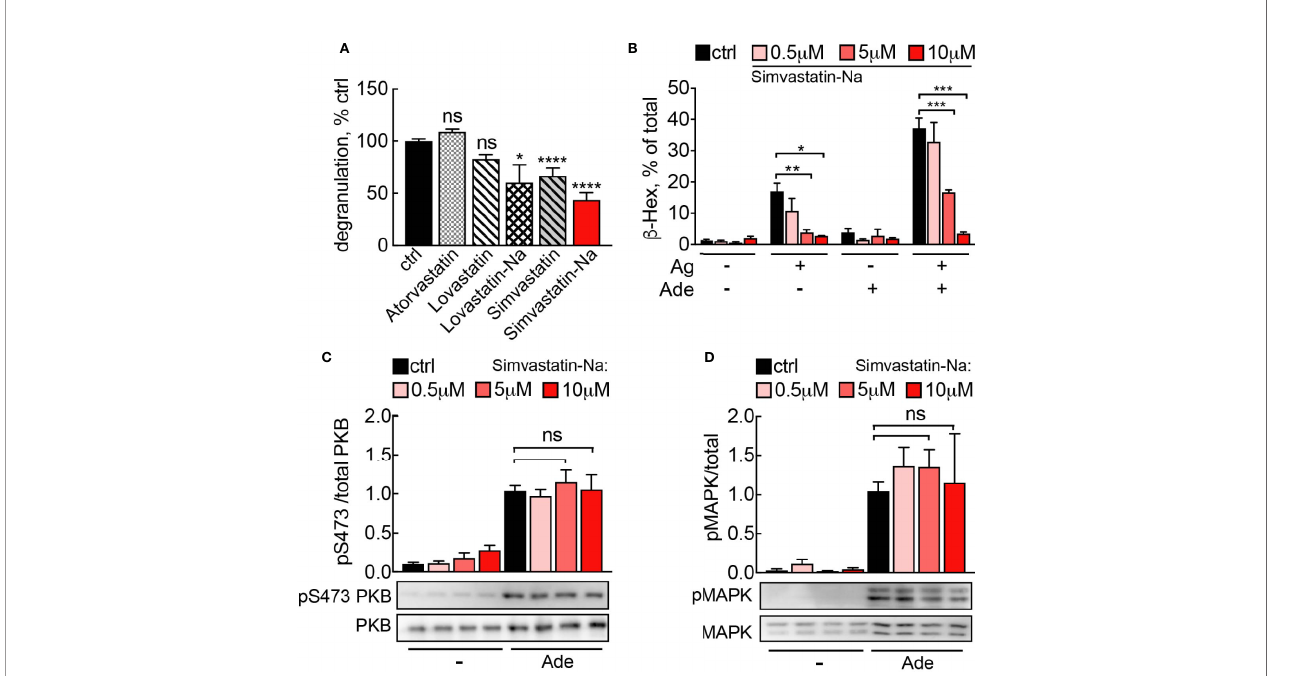
FIGURE 7 | (A) Simvastatin inhibits mast cell degranulation without interfering with PI3K g signaling. BMMCs were treated with indicated statins at 5 µM for 16 h and then loaded with anti-DNP IgE (100 ng/ml). The following day, cells were stimulated with DNP-HSA (Ag, 2 ng/ml) plus 2 µM adenosine. Release of b -Hexosaminidase was quanti fi ed 20 min after stimulation and normalized to untreated control (ctrl= DMSO 0.05% for Lovastatin and Simvastatin; PBS 0.001% MetOH for Atorvastatin). Lovastatin (n = 4 – 7) and Simvastatin (n = 10 – 16) are pro-drugs, while Atorvastatin (n = 4), Simvastatin-Na (n = 10 – 16) and Lovastatin-Na (n = 4 – 7) are active drugs. (B) Dose dependency for Simvastatin-Na was tested in three independent experiments with total n = 9 biological replicates. Degranulation was assessed with IgE/antigen-stimulation alone (Ag, DNP-HSA 2 ng/ml) and IgE/antigen co-stimulation with adenosine (2 µM). (C, D) Western blot analysis of BMMCs treated with 5µM Simvastatin-Na for 16 h and starved for 4 h. Adenosine (2 µM) was used as stimulus. Phosphorylated PKB and MAPK was quanti fi ed from n = 3 – 9 experiments. Statistical signi fi cance was tested with one-way ANOVA applying Bonferroni